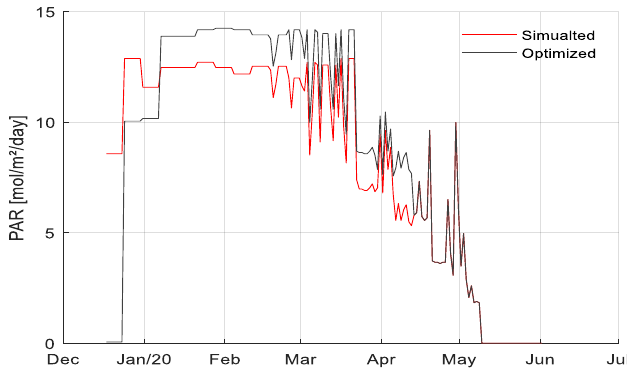
Figure 23. Daily amount of light (mol / m 2 / d) as applied in reality (blue line) and the simulated optimized amount of light (red line) leading to optimized net profit in compartment 306.